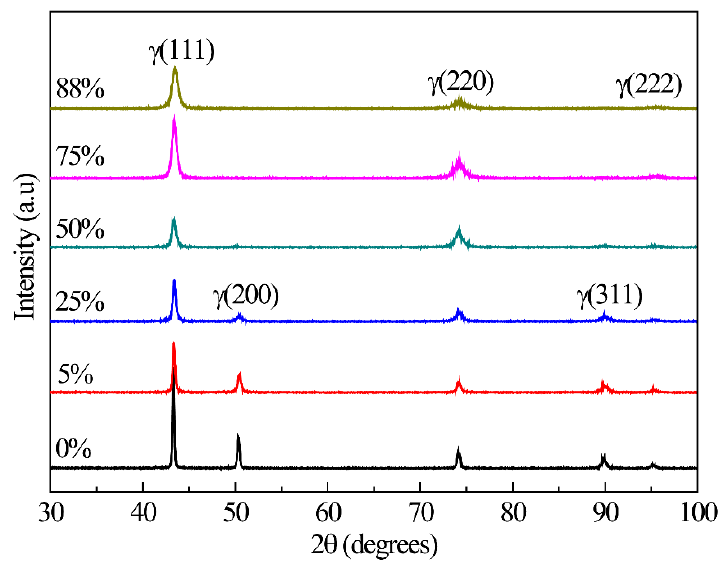
Figure 2. XRD patterns of TWIP steel at 0%, 5%, 25%, 50%, 75%, and 88% CR deformation. The microstructural evolution for Fe–19Mn–0.6C TWIP steel at various CR